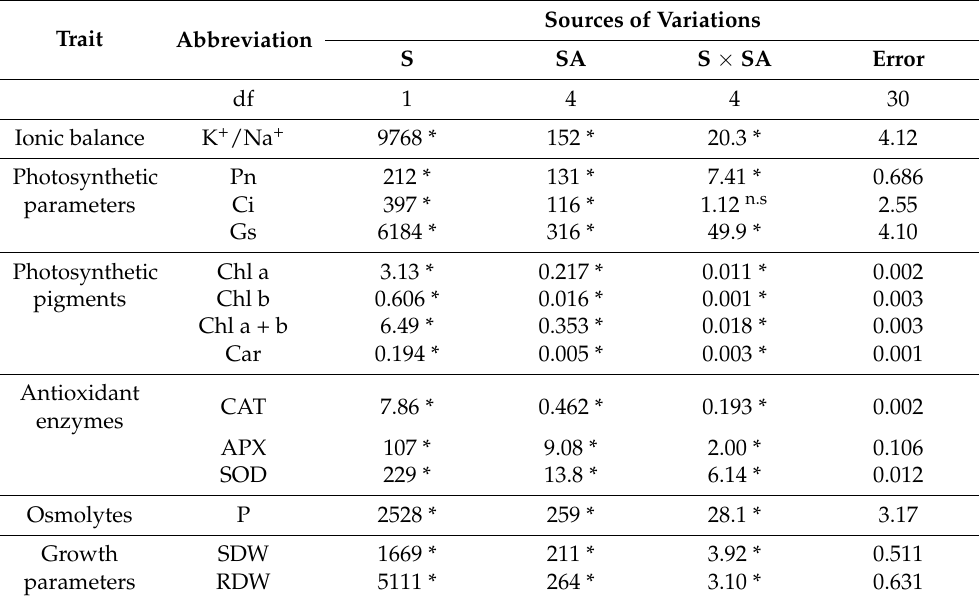
Table 1. Analysis of variances ANOVA (mean squares) for different parameters of sorghum in two levels salinity and five levels of foliar application salicylic acid in four repetitions.